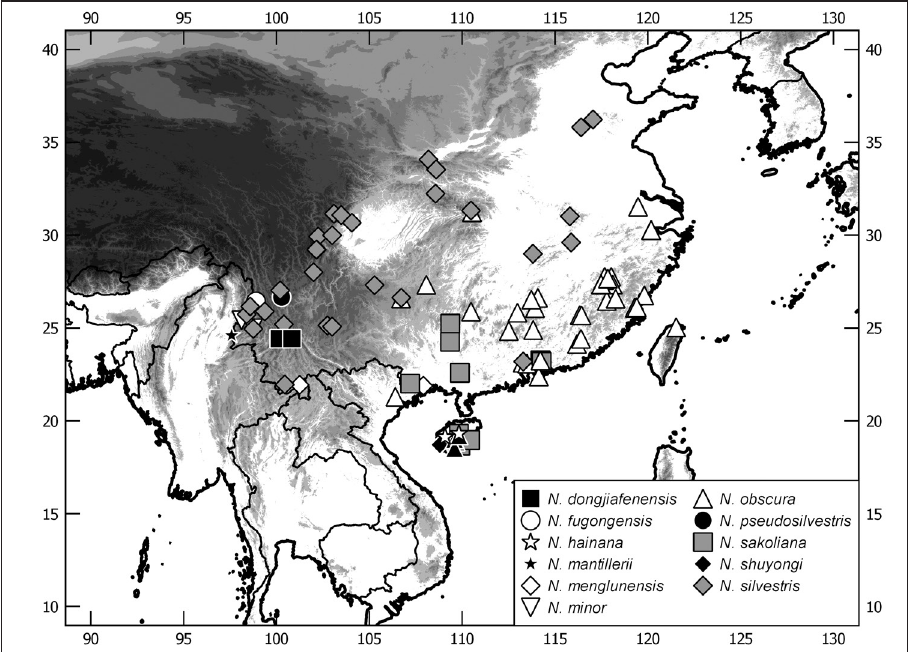
Figure 6. Distribution of the species of the Neoserica obscura , N. lubrica and N. silvestris groups [in China]